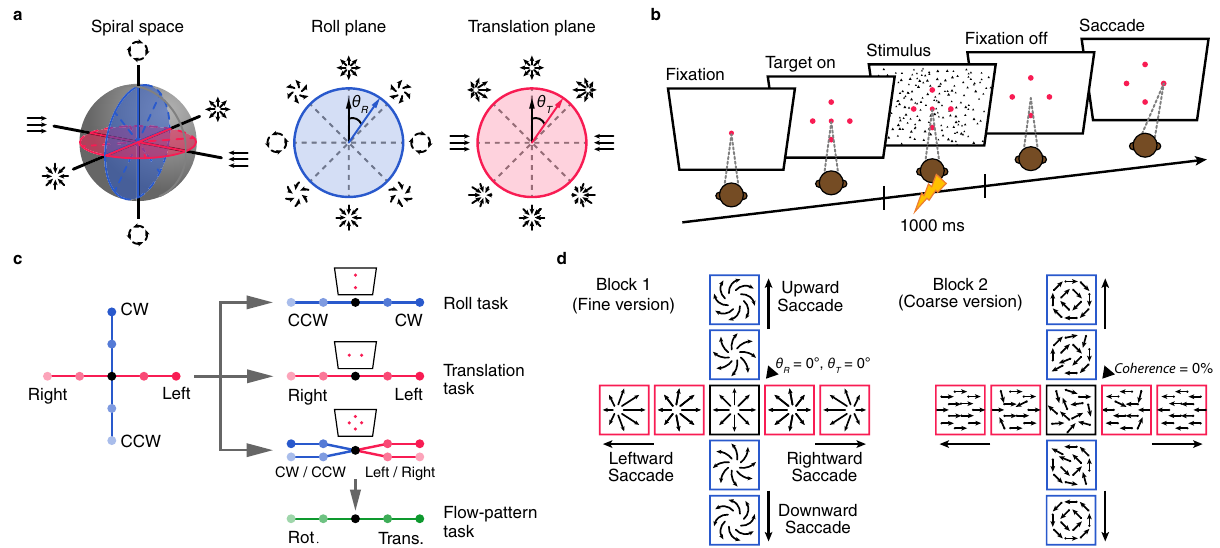
Fig. 1 | Experimental protocol. a Schematic plot of the 3D spiral space (left), roll plane (middle) and translation plane (right). Complex optic fl ow pattern used in tuning measurement and discrimination task were selected from the two perpendicular planes based on deviation in rotation component ( θ R ) and translation component ( θ T ) from straight forward ( θ R =0 (cid:1) , θ T =0 (cid:1) ). b Events fl ow in the main 4-AFC discrimination tasks. Each trial was initiated with a center fi xation point and four choice targets appeared symmetrically around the fi xation point (top, down, left, and right). c Each 4-AFC task can be divided